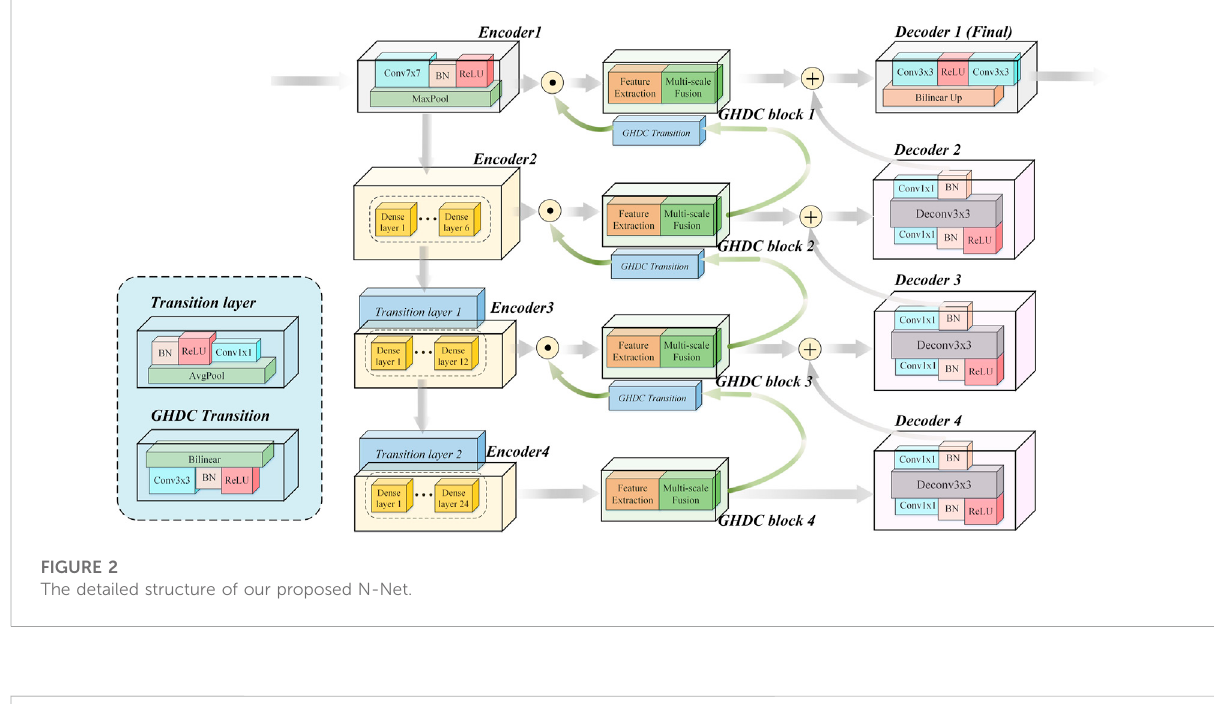
FIGURE 2 The detailed structure of our proposed N-Net.